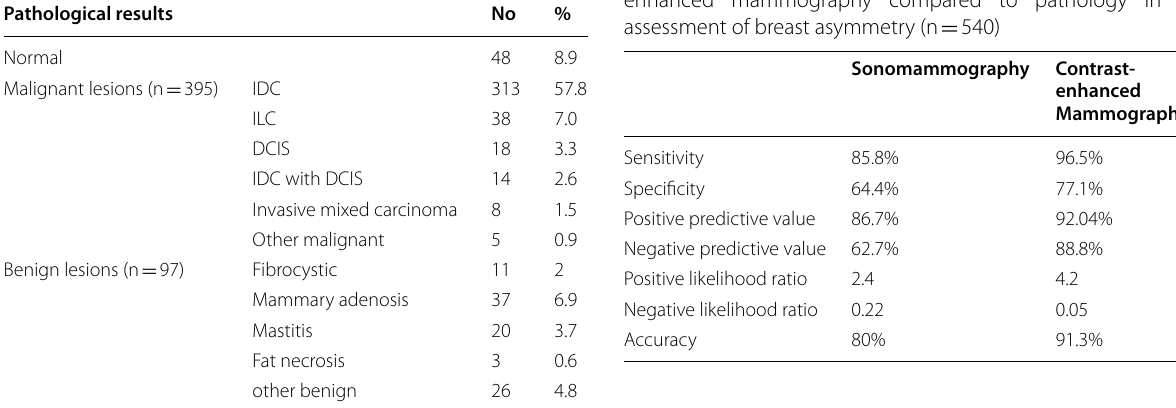
Table 4 Histopathological results (n